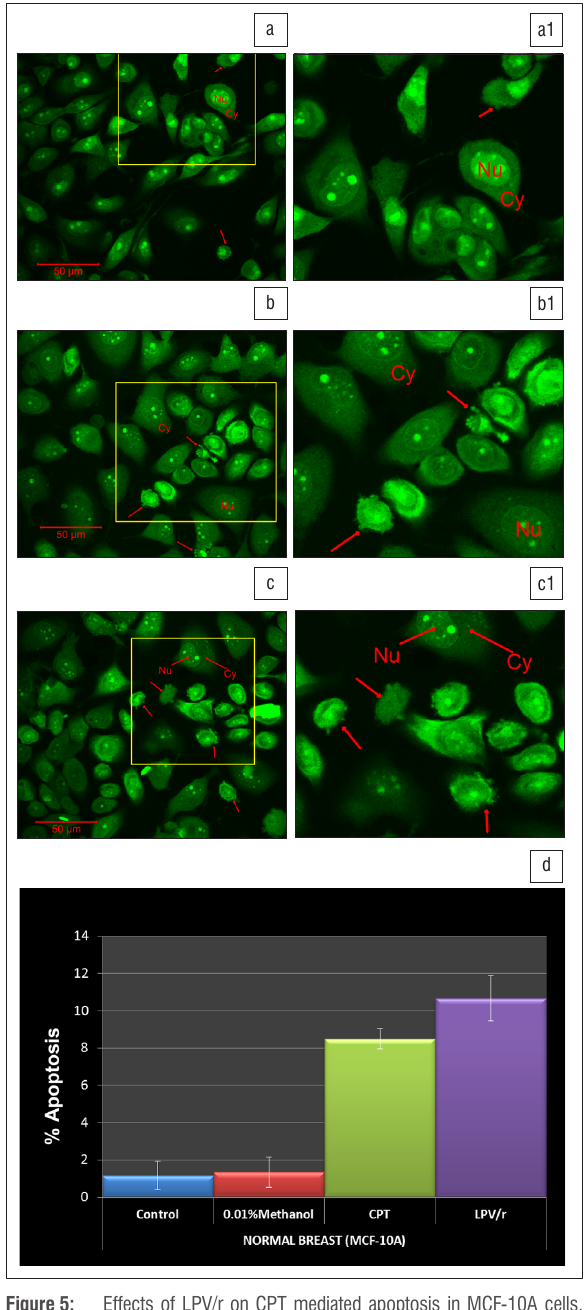
Figure 5: Effects of LPV/r on CPT mediated apoptosis in MCF-10A cells. (a) Untreated control MCF-10A cells. (b) CPT treated MCF-10A cells. MCF-10A cells were stimulated with 30 µM CPT for 6 h without prior exposure to LPV/r. (c) MCF-10A cells incubated with LPV/r prior to apoptosis induction. Apoptosis was assessed using acridine orange staining. Arrows point to apoptotic bodies and cells undergoing apoptosis with the characteristic feature of membrane blebbing. Areas within the box are magnified to the right (a1, b1, c1). (d) A total of 600 cells per group was counted from three independent experiments to determine the percentage of apoptotic cells. LPV/r had no significant inhibitory effects on CPT induced apoptosis in MCF-10A